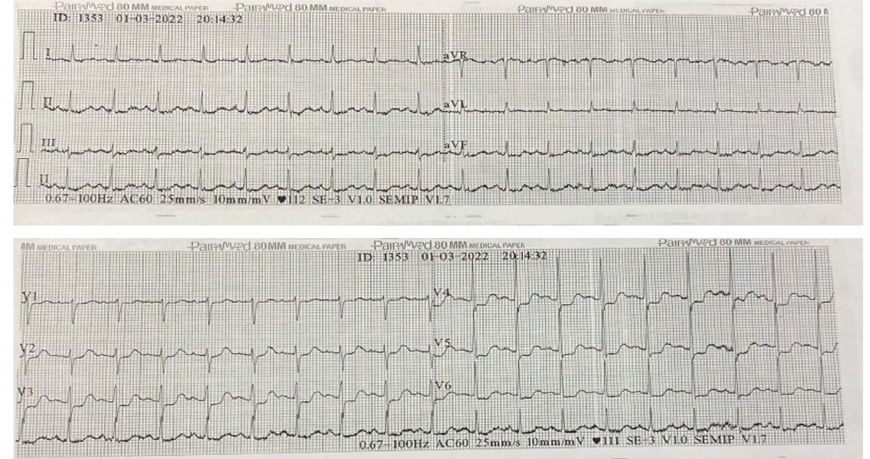
Figure 1: Initial electrocardiogram of the referral site. Sinus rhythm and ST-segment depression in V4-V5-V6 (lateral